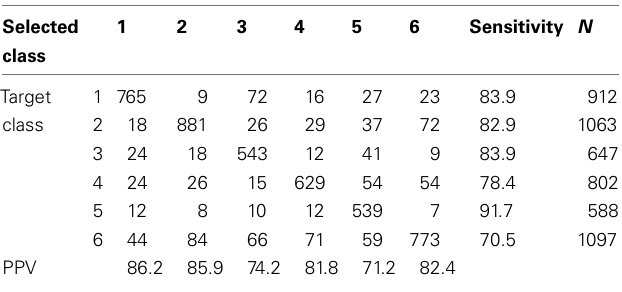
Table 3 | Grand-average confusion